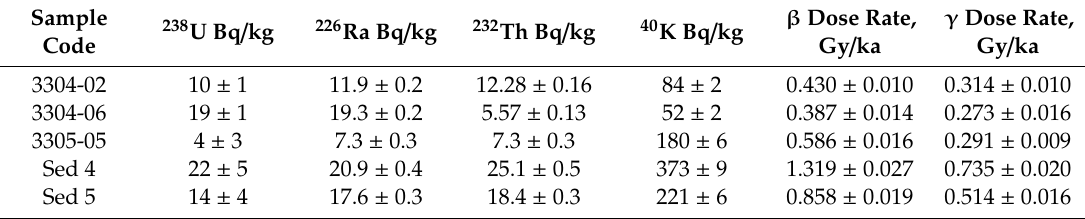
Table 3. Radionuclide concentrations and dry infinite matrix dose rates for selected samples.